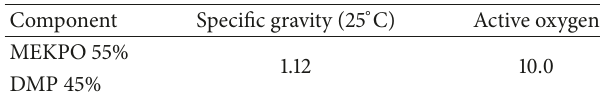
Table 3: Properties of